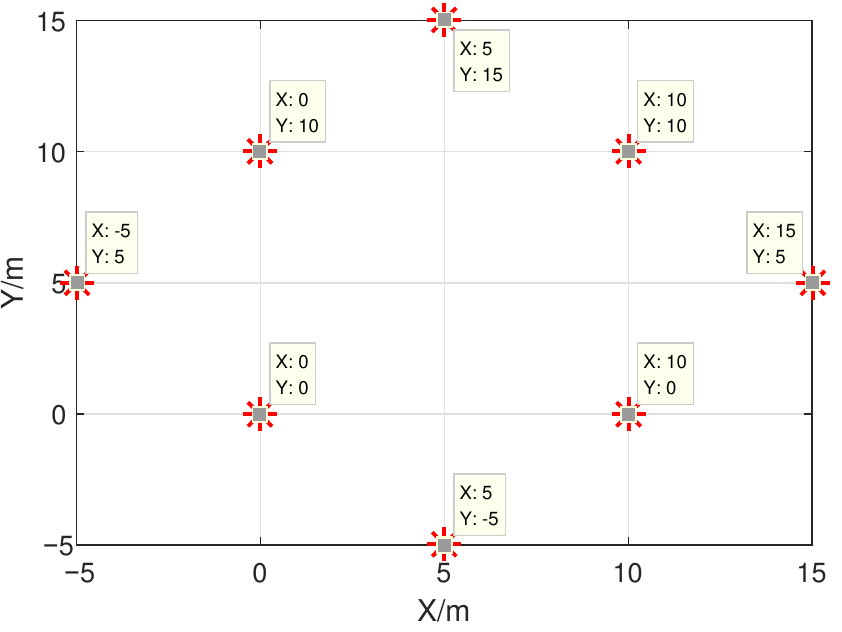
Figure 1. Coordinate diagram of base